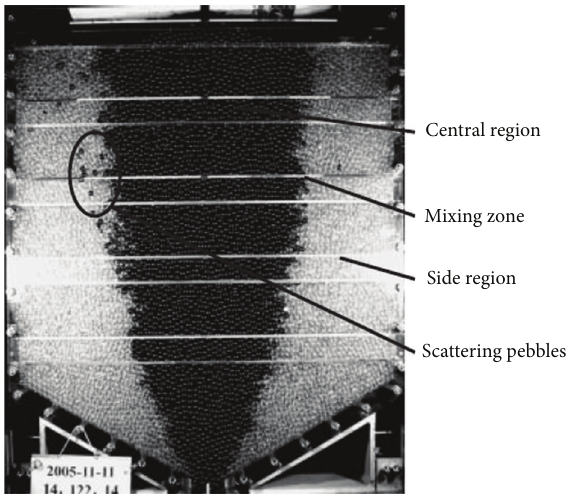
Figure 4: Establishment of the two-region arrangement in experi- ment without guide plates.